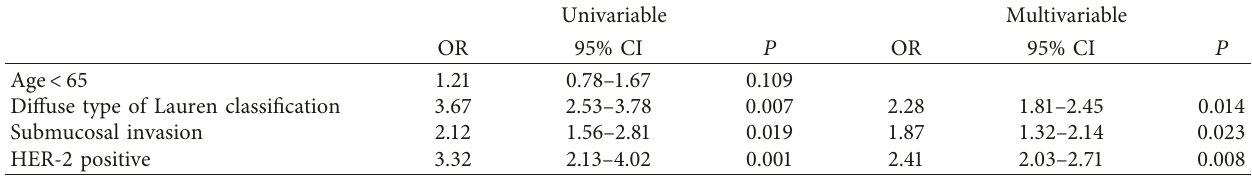
Table 2: Univariable analysis and multivariable logistic regression analysis for residual cancer.